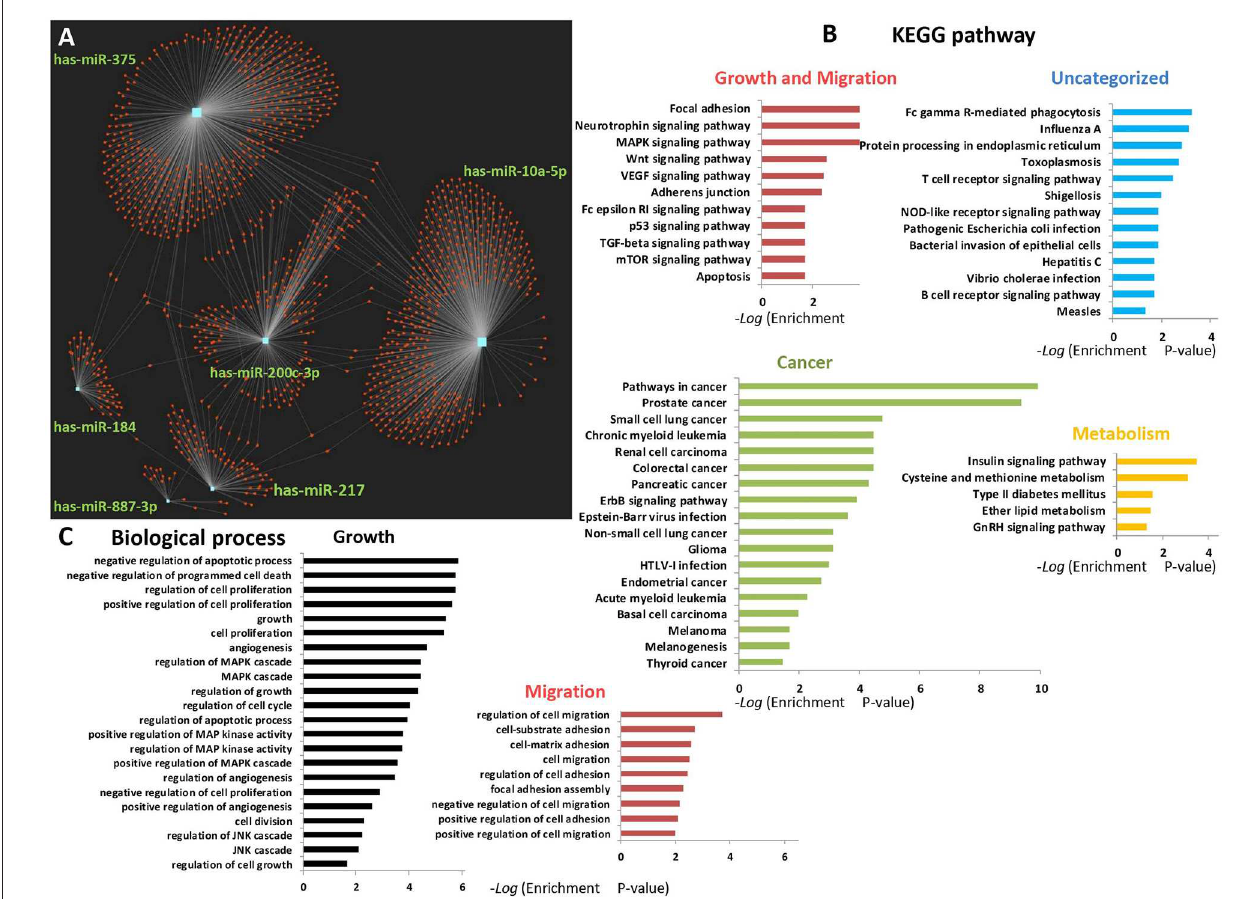
FIGURE 5 | Network and pathway enrichment of 6 human miRNA targets. Six selected miRNAs (miR-10a, miR-887, miR-184, miR217, miR375, and miR-200C) were analyzed by miRNet tool for gene targets, and miR-gene network, pathway, and function enrichment (https://www.mirnet.ca/). (A) 1,306 gene targets for 6 miRNAs are presented. (B) Enriched pathways for migration, cancer, metabolism, and uncategorized. (C) Enriched biological processes for migration and growth. The KEGG analysis was performed on all 47 significantly enriched pathways. The biological process analysis includes functions of interest extracted from 242 significant results ( p <